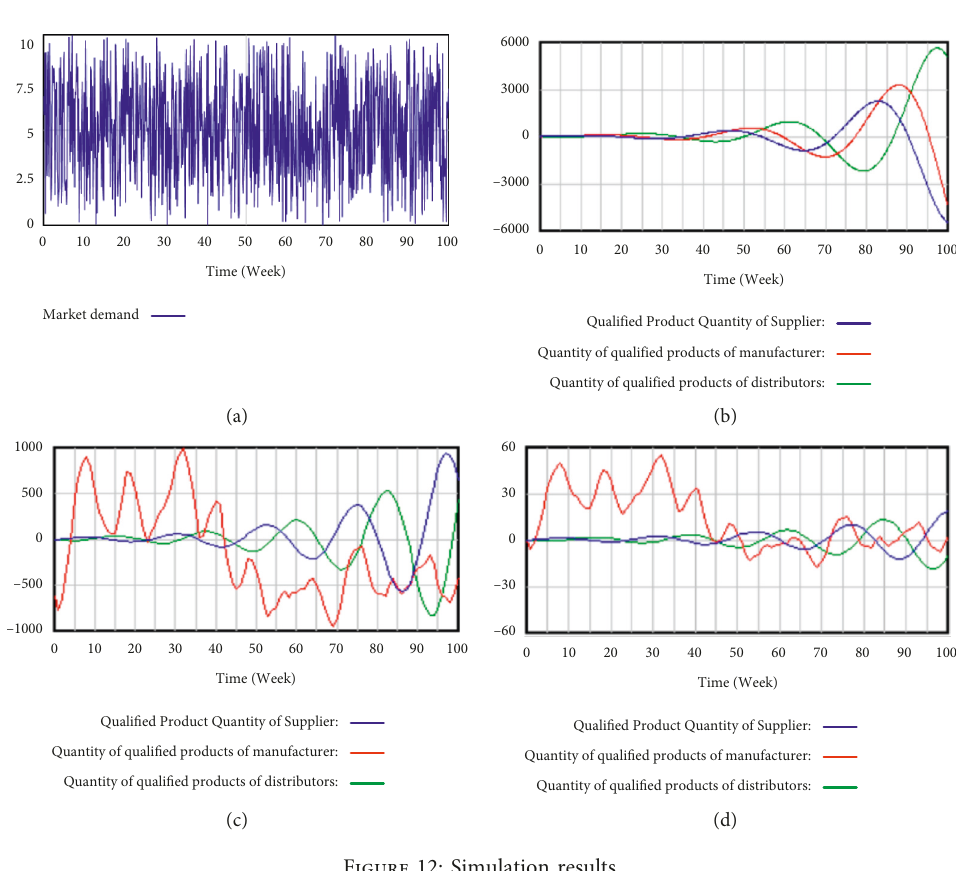
Figure 12: Simulation